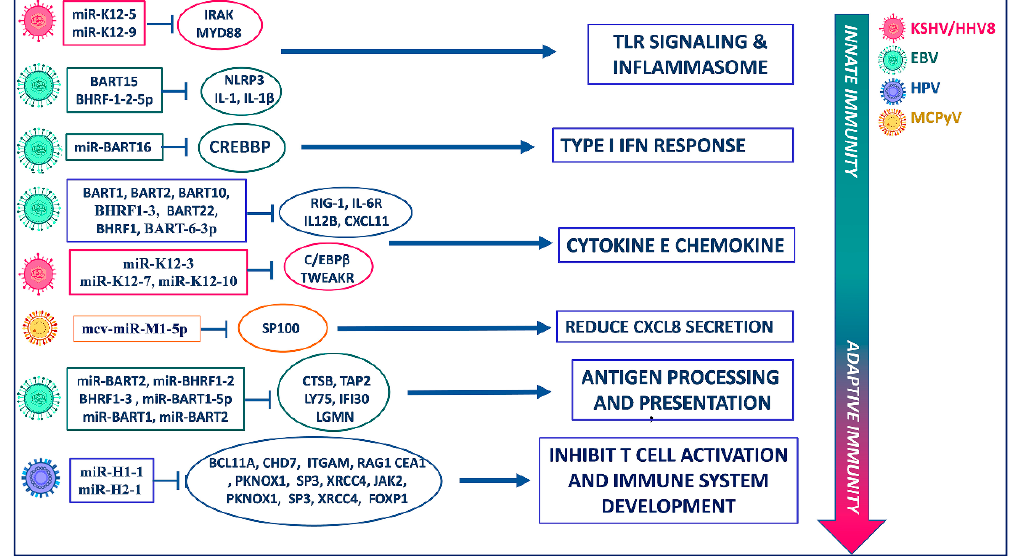
Figure 2. Immunoevasive functions of viral miRNAs. Target cellular components of EBV, KSHV, and HPV miRNAs and the relavant antiviral responses of innate and adaptive immunity.